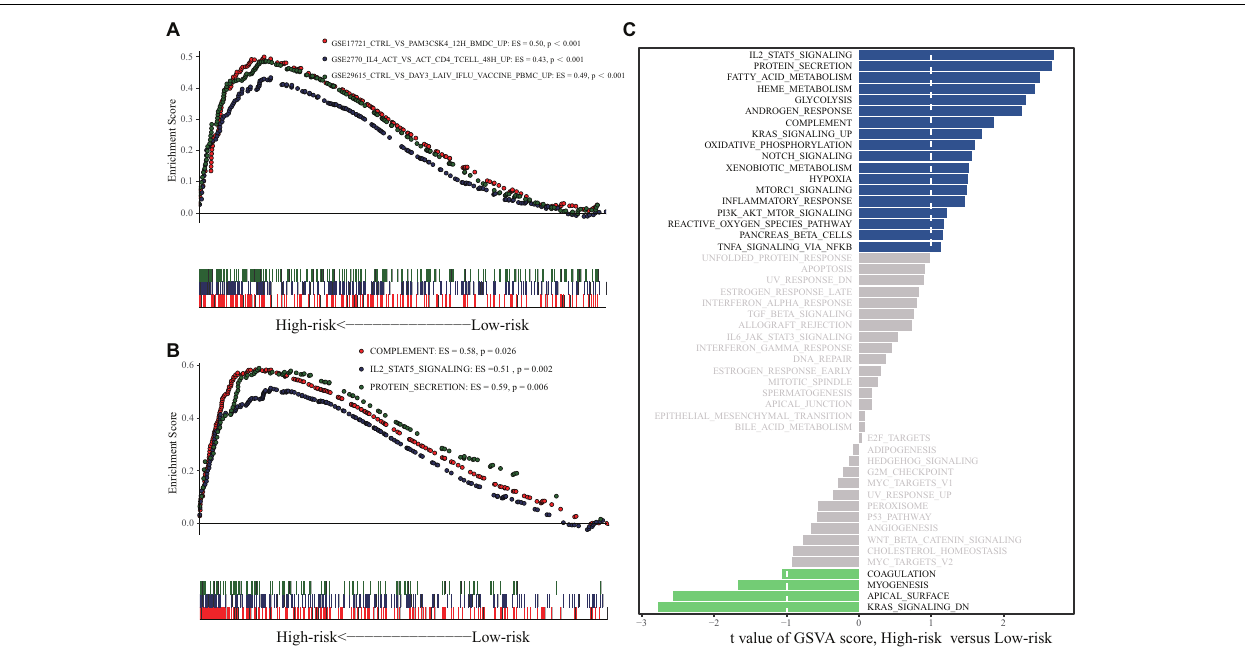
FIGURE 10 | GSEA and GSVA analyses. (A) GSEA analysis based on h.all.v7.1.symbols.gmt. (B) GSEA analysis based on c7.all.v7.1.symbols.gmt. (C) GSVA analysis.